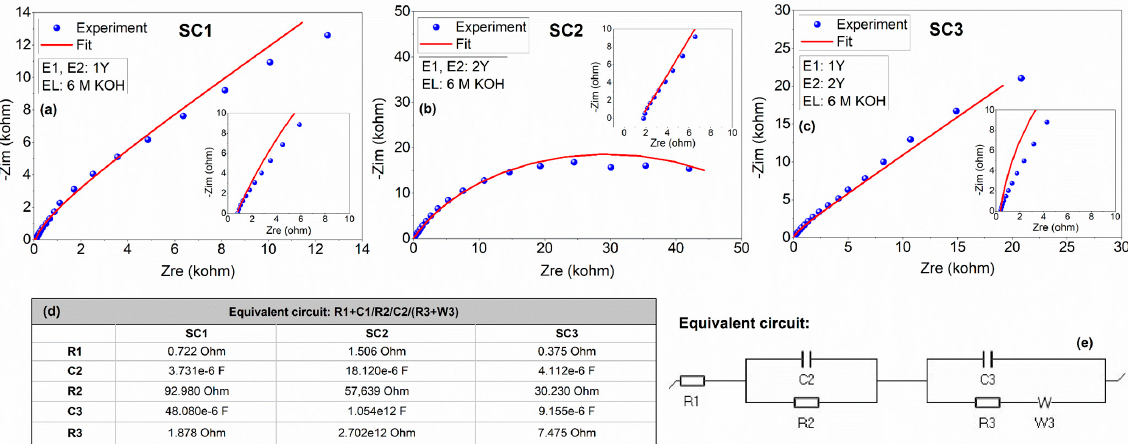
Figure 7. Experimental and fitted impedance data for the symmetric and asymmetric all-in-one supercapacitors in 6 M KOH electrolyte: Nyquist profiles of ( a ) SC1, ( b ) SC2, and ( c ) SC3; ( d ) fitted equivalent circuit elements of symmetric and asymmetric SCs; and ( e ) the equivalent circuit. The insets show high frequency regions of the spectra.